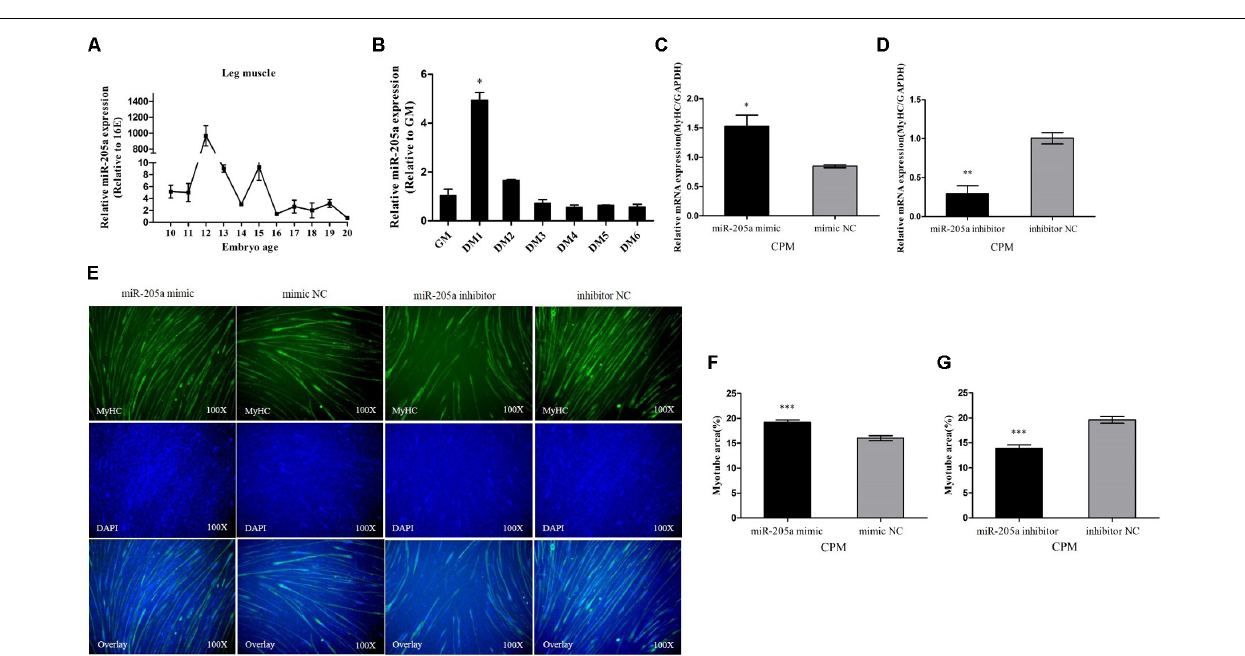
Frontiers in Genetics |